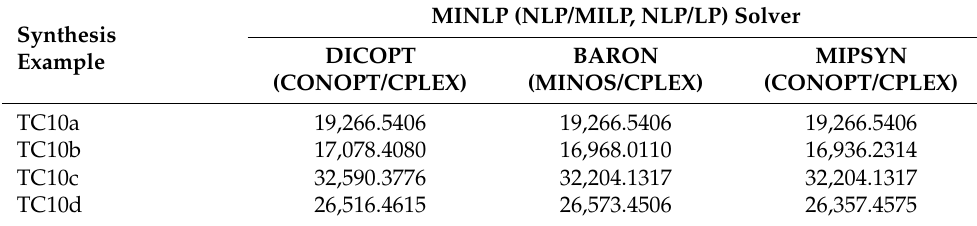
Table 10. Results obtained by using different MINLP solvers.